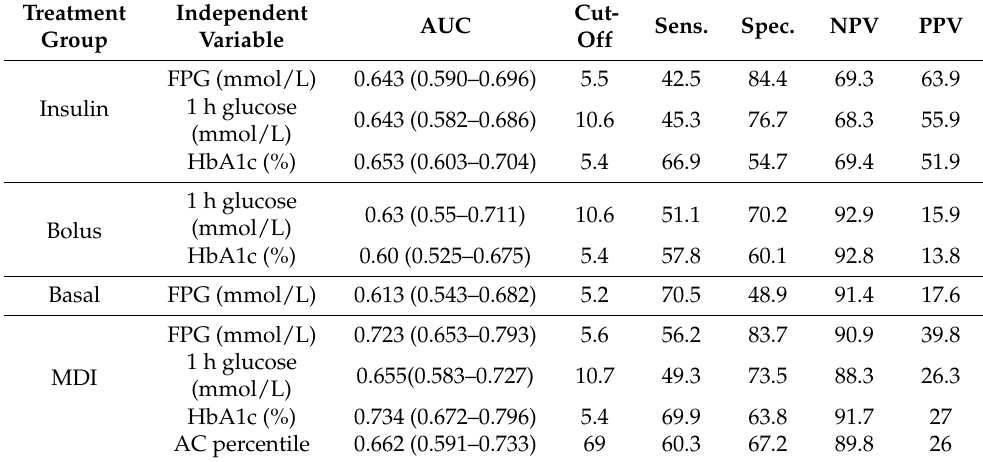
Table 3. Presentation of cut-off values, sensitivity, specificity, negative predictive value and positive predictive value of independent